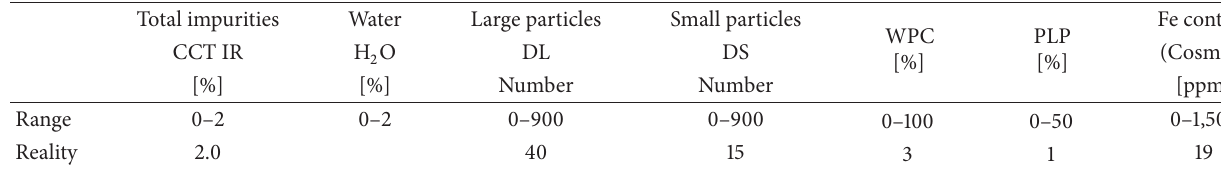
Table 7: The measurement results for sample D.